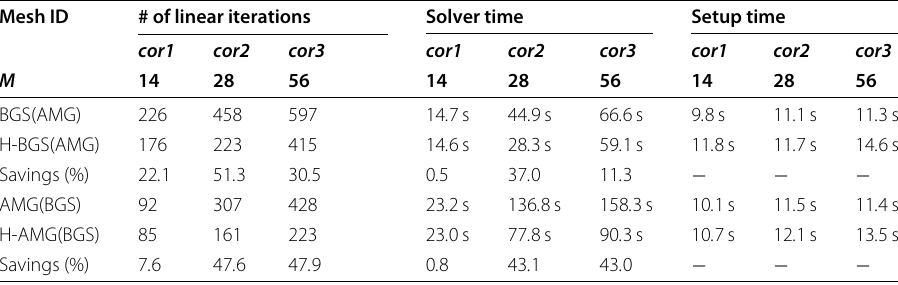
Table 8 Iteration counts and time measurements per time step for comparison of physics-based block preconditioners and the newly proposed hybrid preconditioner in the Coriolis flow meter